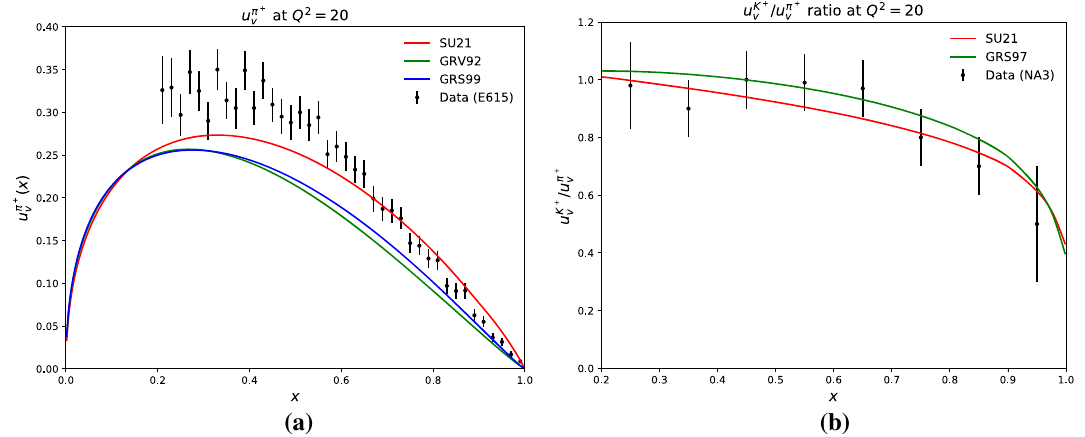
Fig. 2 a Pion PDFs, comparing our simplified form to GRV92 and GRS99, and to data. b ¯ u K − v / ¯ u π − v ratio, comparing our simplified param- eterization on the form given in Eq. (14) to the slightly more detailed